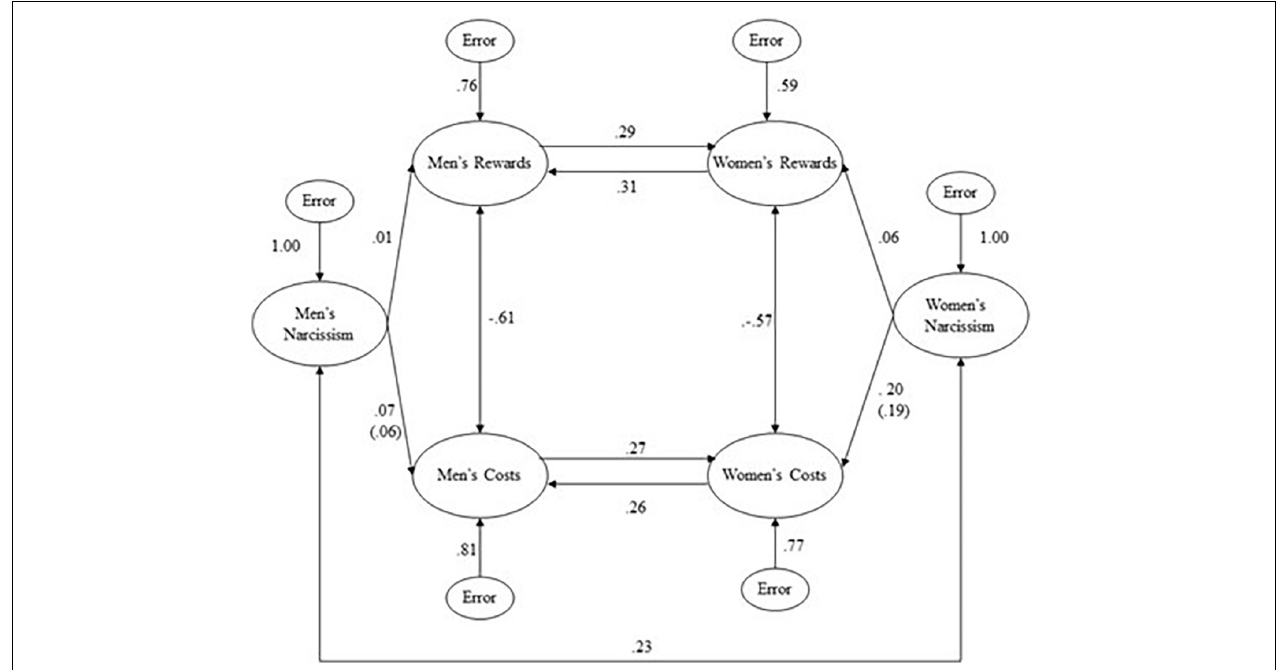
FIGURE 1 | Covariance structure model of men’s and women’s narcissism, rewards, and costs (final N = 177 couples). All beta coefficients and correlations with absolute values greater than 0.25 are significant ( ps < 0.05 or